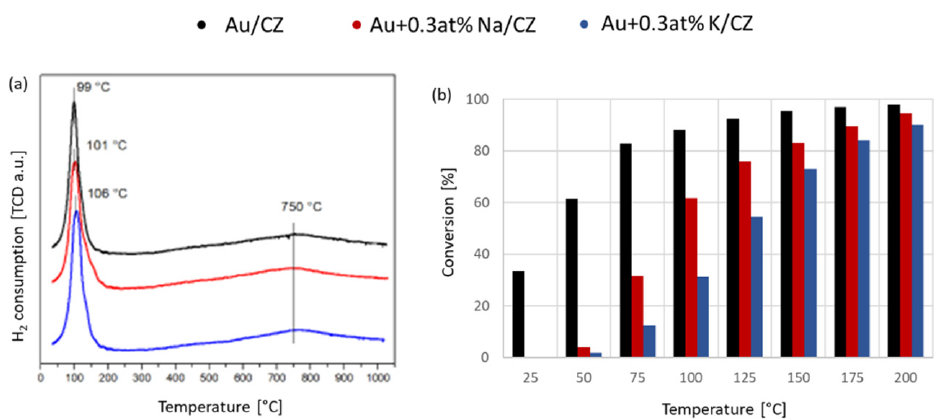
Figure 6. TPR curves ( a ) and CO oxidation activity ( b ) of Au/CZ, Au + 0.3 at% Na/CZ and Au + 0.3 at% K/CZ.